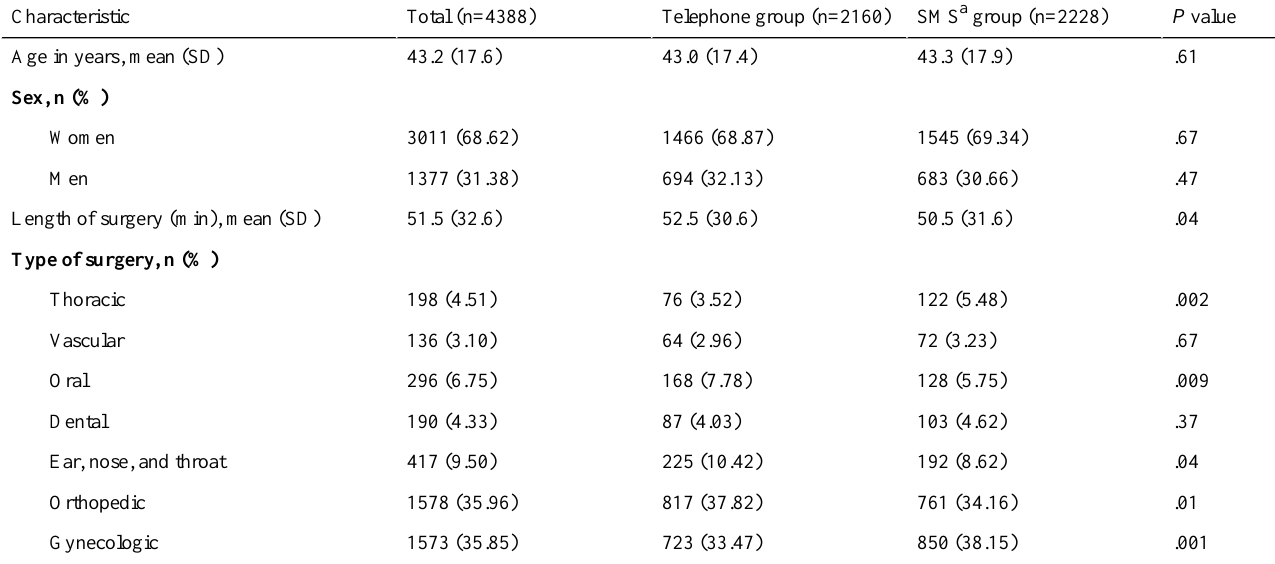
Table 1. Patient characteristics